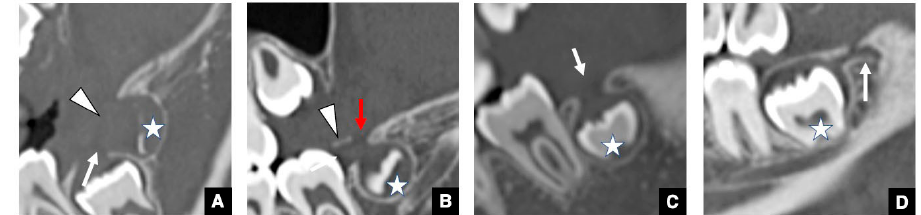
Figure 3. Representative CBCT images of various periods of GTs in mandibular molar regions with normal tooth eruption, ( A ) GT (arrow) of the maxillary third molar bud (star) in the stage of groove-shaped GT on a parallel sectional CBCT image. The alveolar crest bone (arrowhead) on the GT is not observed because of immaturity. ( B ) GT (arrow) of the mandibular third molar (star) in the Y-shape staged on a parallel sectional CBCT image. The alveolar crest bone (arrowhead) on the GT appears, and the ductal form becomes clear. Notably, the GT consisted of two forms in the penetrating area: one was directed mesially as a parallel part (arrow), and the other was directed vertically to the alveolar crest as a perpen- dicular part (red arrow). As a result, the GT forms a Y-shape. ( C ) GT (arrow) of the mandibular third molar (star) in the mature stage on a parallel sectional CBCT image. The GT runs perpendicularly from the DS to the alveolar crest. ( D ) CBCT image of the pseudo-GT (arrow) continuing from the distal side of the mandibular third molar (star).